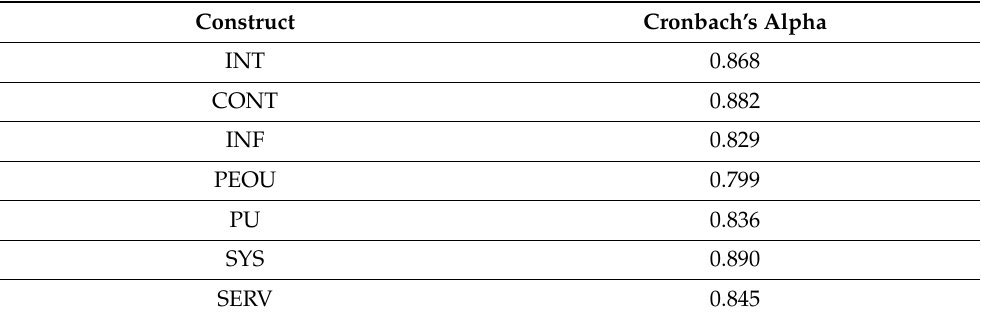
Table 2. The pilot